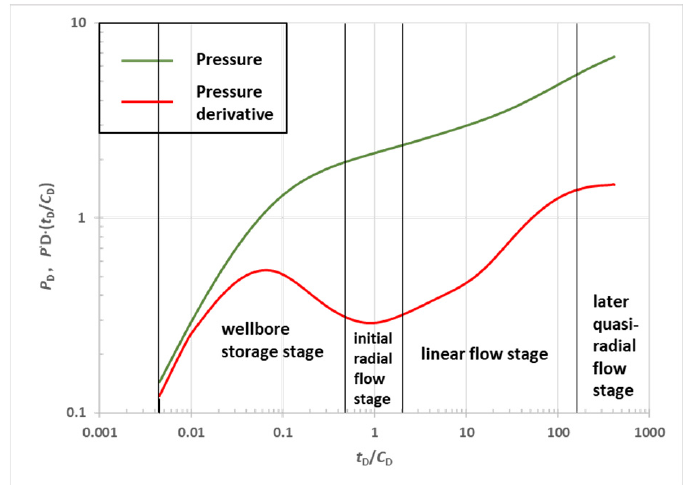
Figure 5. Double logarithmic pressure and pressure derivative diagram of horizontal well test.